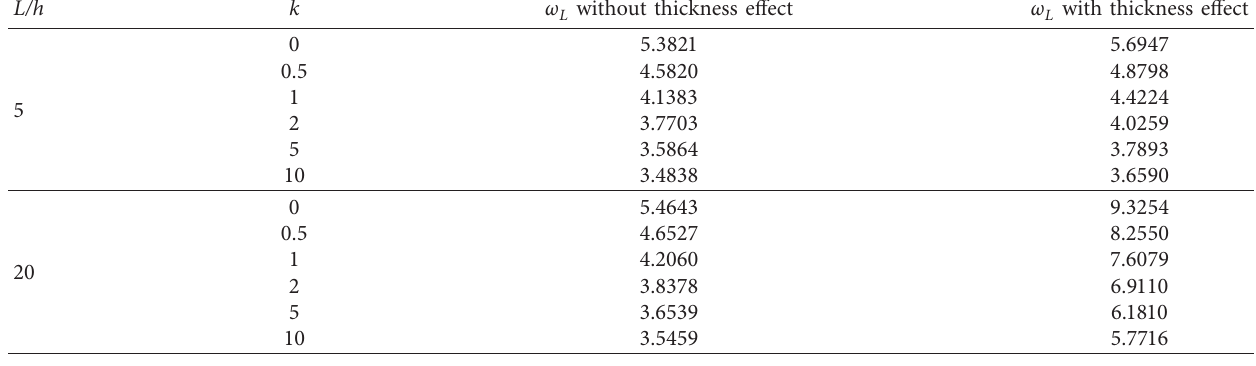
Table 5: The first nondimensional natural frequencies of FG nanobeams for α � 0 . 02 and β � 0 . 03.